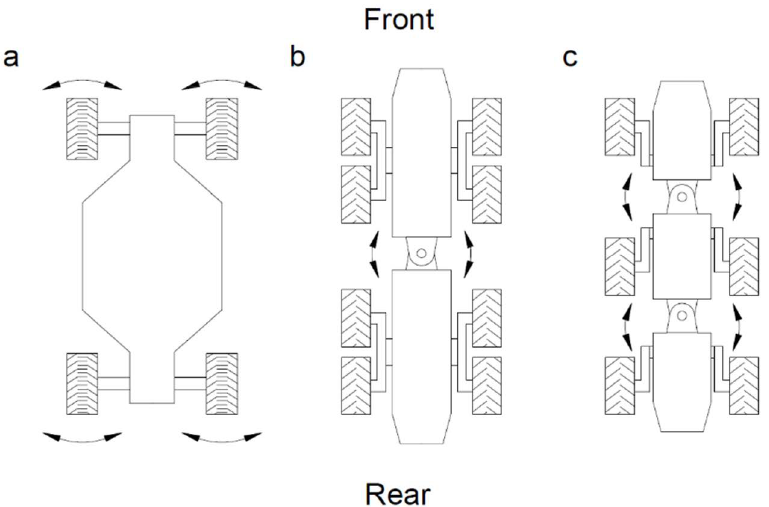
Figure 1. ( a ) rigid frame of the harvester AH6, ( b ) conventional articulated frame, ( c ) frame of the Figure 1. ( a )/rigid frame of the harvester AH6, ( b )/conventional articulated frame, ( c )/frame of the forwarder XT28. forwarder